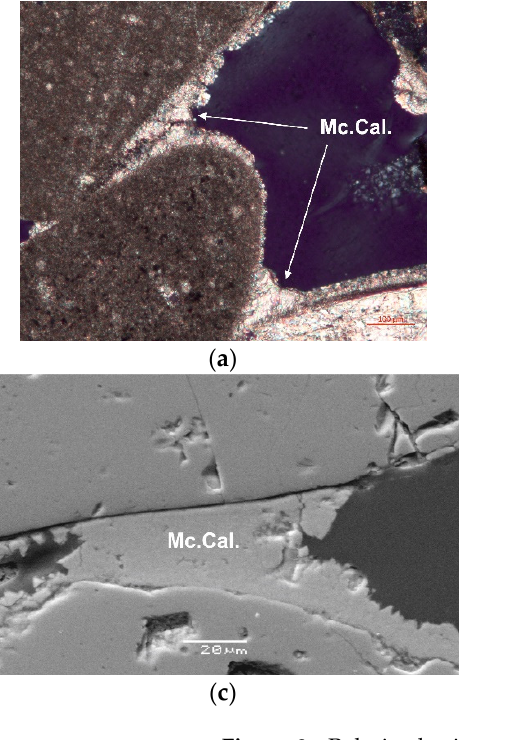
Figure 9. Polarized microscopy image of sample ArDI1 at ( a ) 20x magnification, scale 100 μ m. Microcrystalic calcite cement is coating sediment grains and ( b ) 20x magnification, scale 100 µ m. Micritic and spiritic calcite cement forming fan shape grain coating. SEM images of sample ArDI1 ( c ) well developed calcite cement biding two sediment grains, ( d ) calcite cement forming the fan shape grain coating. Qz stands for quartz, Cal for calcite, Mc.Cal. for microcrystalline calcite and Spar. Cal. for spiritic calcite.